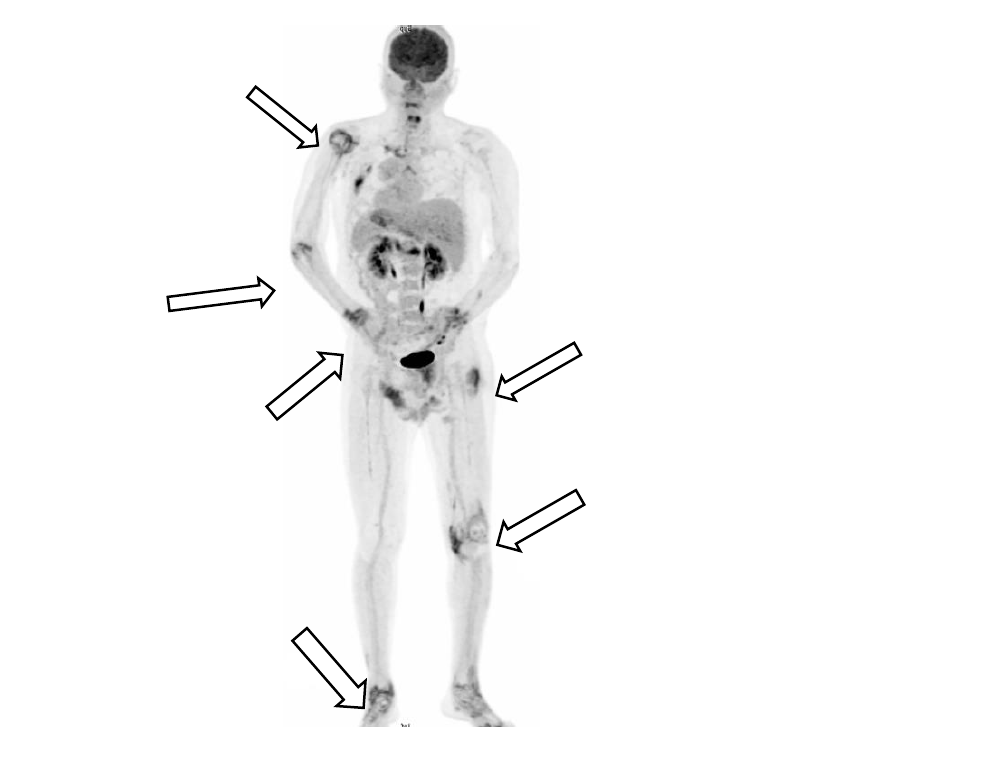
Figure 2. A gallium-67 tumor scan indicated inflammation over left shoulder, left sternoclavicular junction, left interscapular region, lateral right hip region, left buttock, right knee, and left ankle, but no evidence of malignancy.